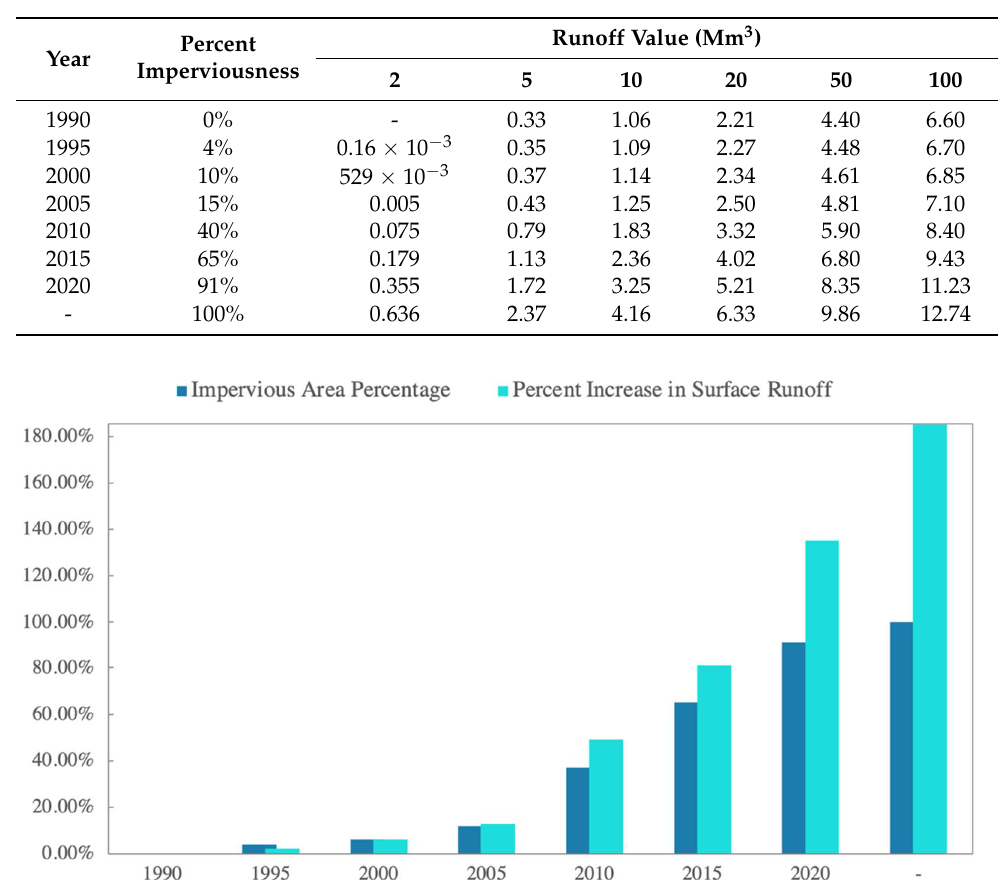
Figure 8. The change in runoff corresponding to the increase of urbanized area from 1990 to 2020 for the whole New Cairo